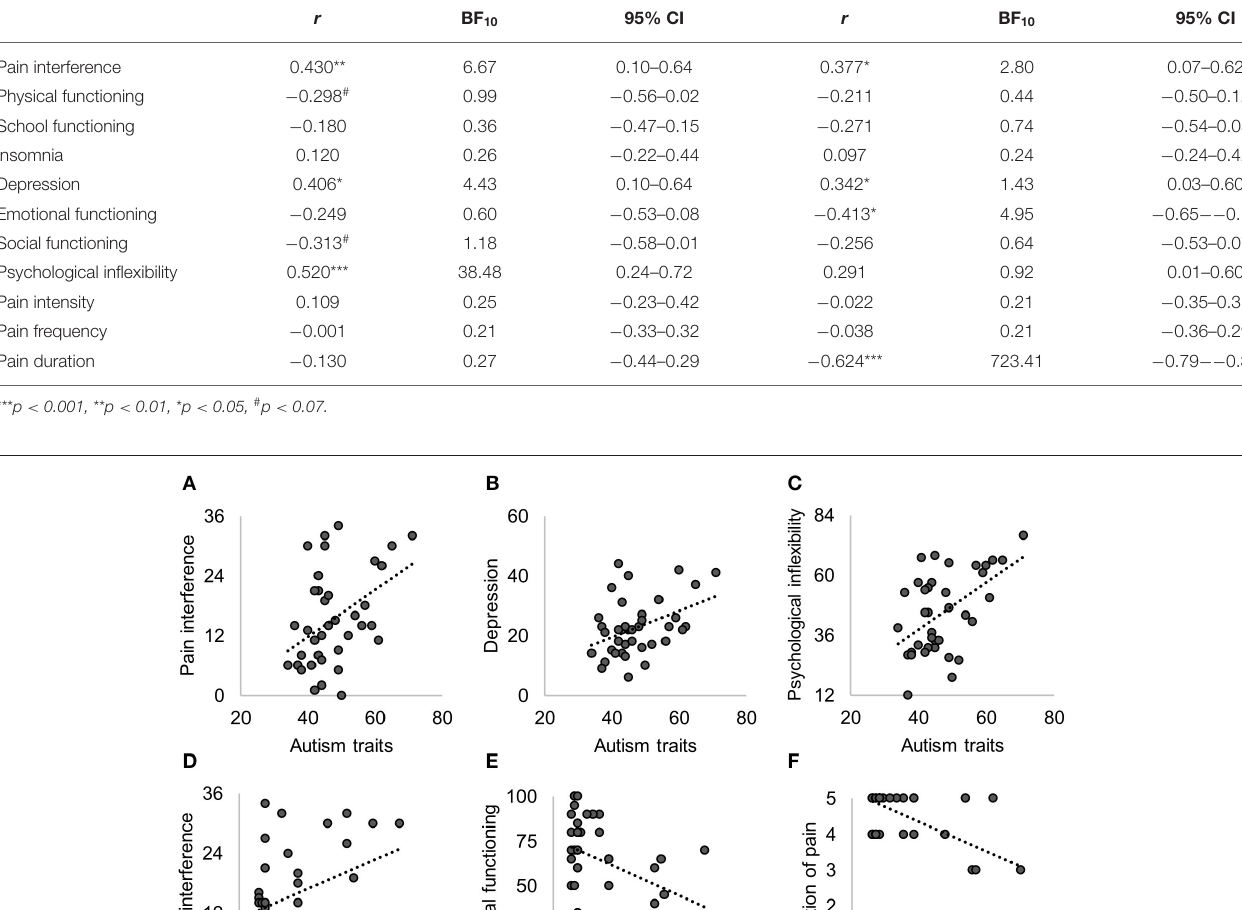
TABLE 2 | Pearson correlation coefficients, 95% confidence intervals (CIs), and Bayes factors (BF 10 ) of each pretreatment outcome with autism traits and with ADHD symptoms. Autism traits